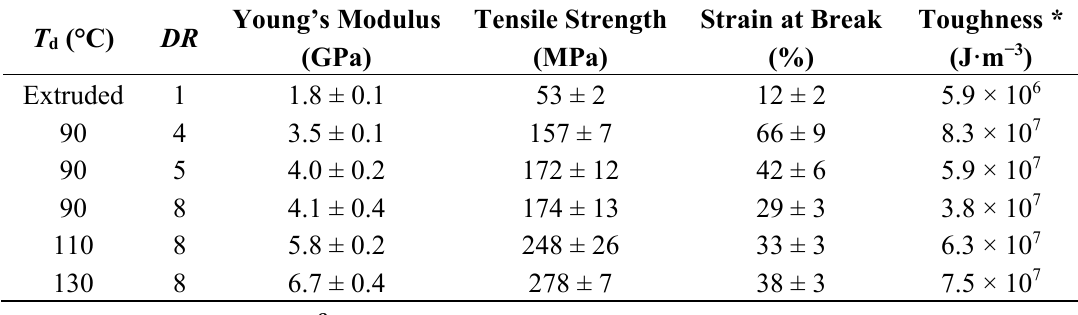
Table 4. Tensile properties of various PLLA